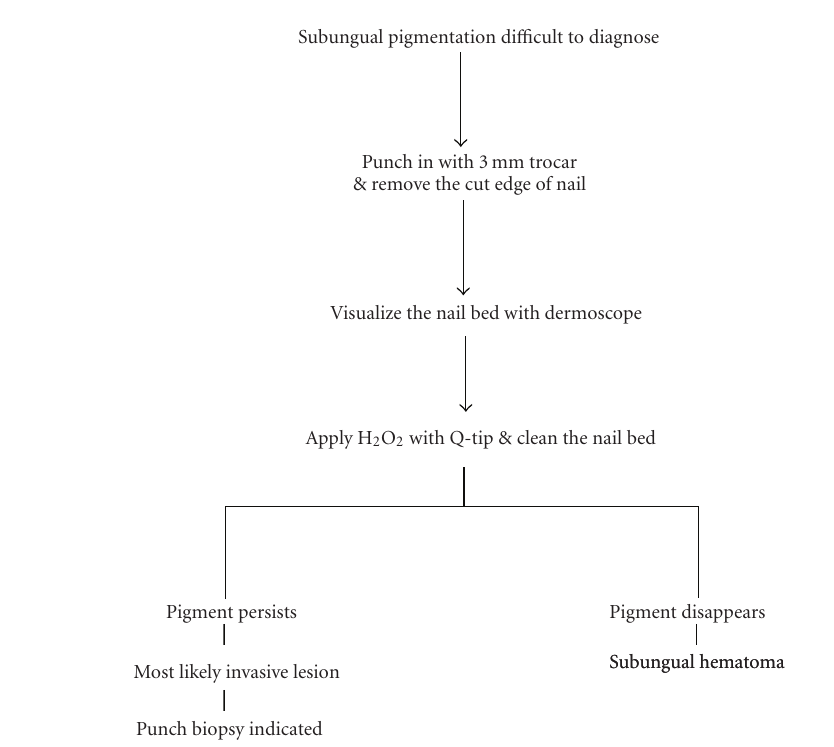
Figure 6: Followup picture of Figure 3 after four weeks. Notice the complete resolution of subungual hematoma leading to clearing of nail bed.